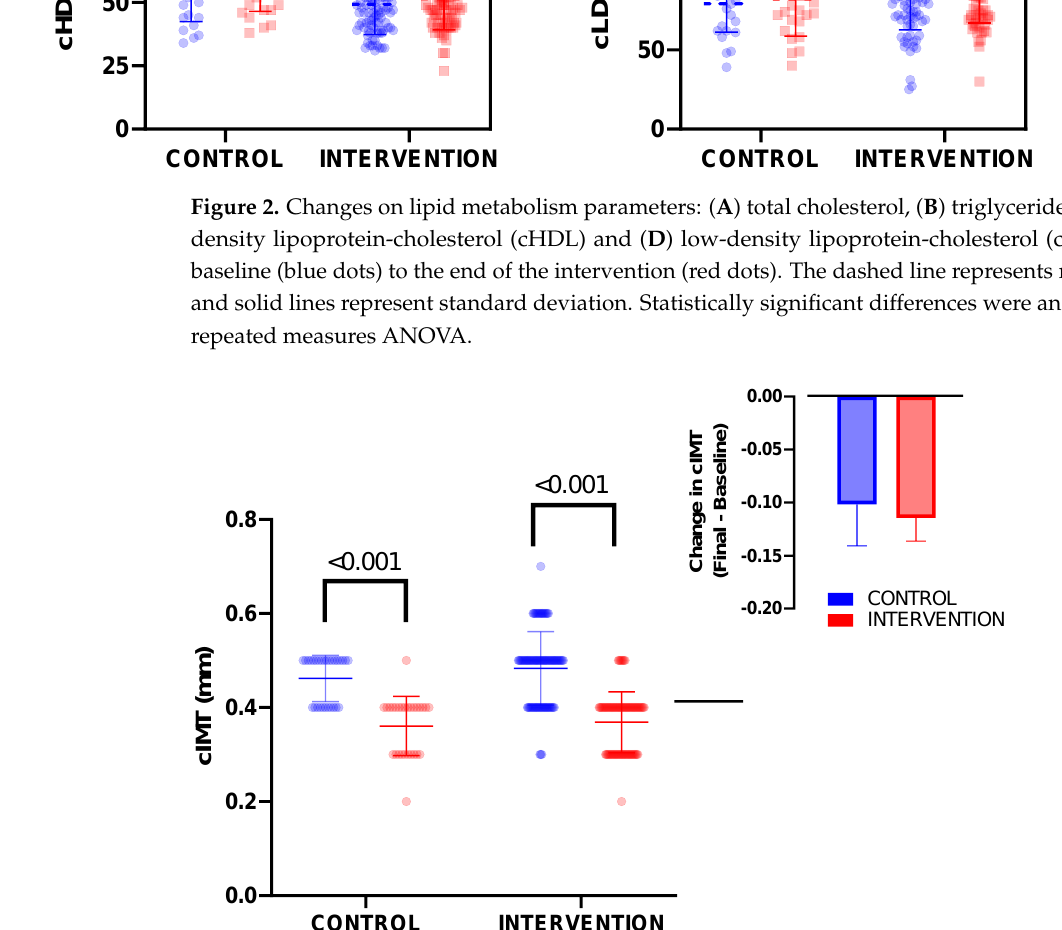
Figure 3. Changes on cIMT in control and Intervention group. The inset represents the cIMT change (final − baseline) in both groups. The intervention significantly decreased cIMT in both groups, although there were no statistically significant differences regarding treatment effectiveness between groups. The data derived from liver echogenicity also showed an improvement after the in- tervention. Concretely, there was an increase in children with normal echogenicity, while there was a similar reduction in children with light echogenicity (Figure 4A). In addition, there were no children with severe echogenicity at the end of the intervention. The shear rate, a measurement of hepatic elasticity, was also reduced because of the intervention in the intervention group, reaching values similar to those of children with normal weight.